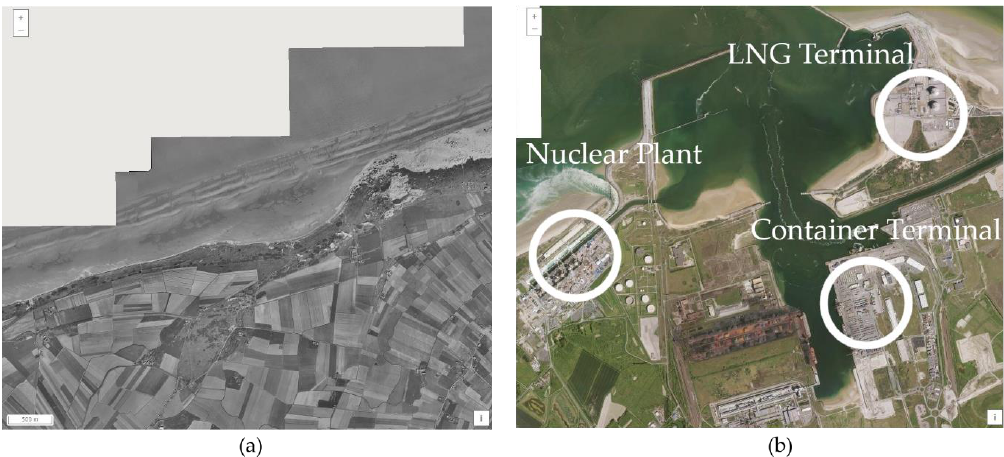
Figure 6. Evolution of the western limit of the port city of Dunkirk. ( a ) The landscape on the western limit of Dunkirk in 1957; ( b ) The landscape of the western limit of Dunkirk in 2018, with circles to highlight the settlement of the nuclear plant of Gravelines and the Liquid Natural Gas (LNG) and Container Terminal. Pictures of the service “remonter le temps” from the French National institute of Geographic and Forest Information (IGN).